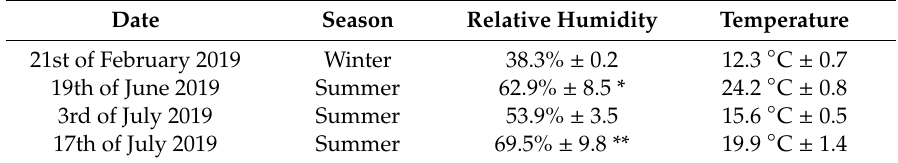
Table 1. Samples for this study were taken over four separate sampling days, one in the winter and three in the summer of 2019. The average and standard deviation of the relative humidity and temperature are shown for each sampling